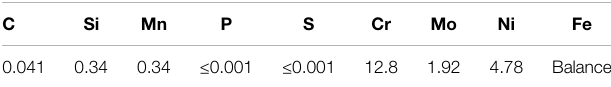
TABLE 1 | Elemental composition of super 13Cr SS